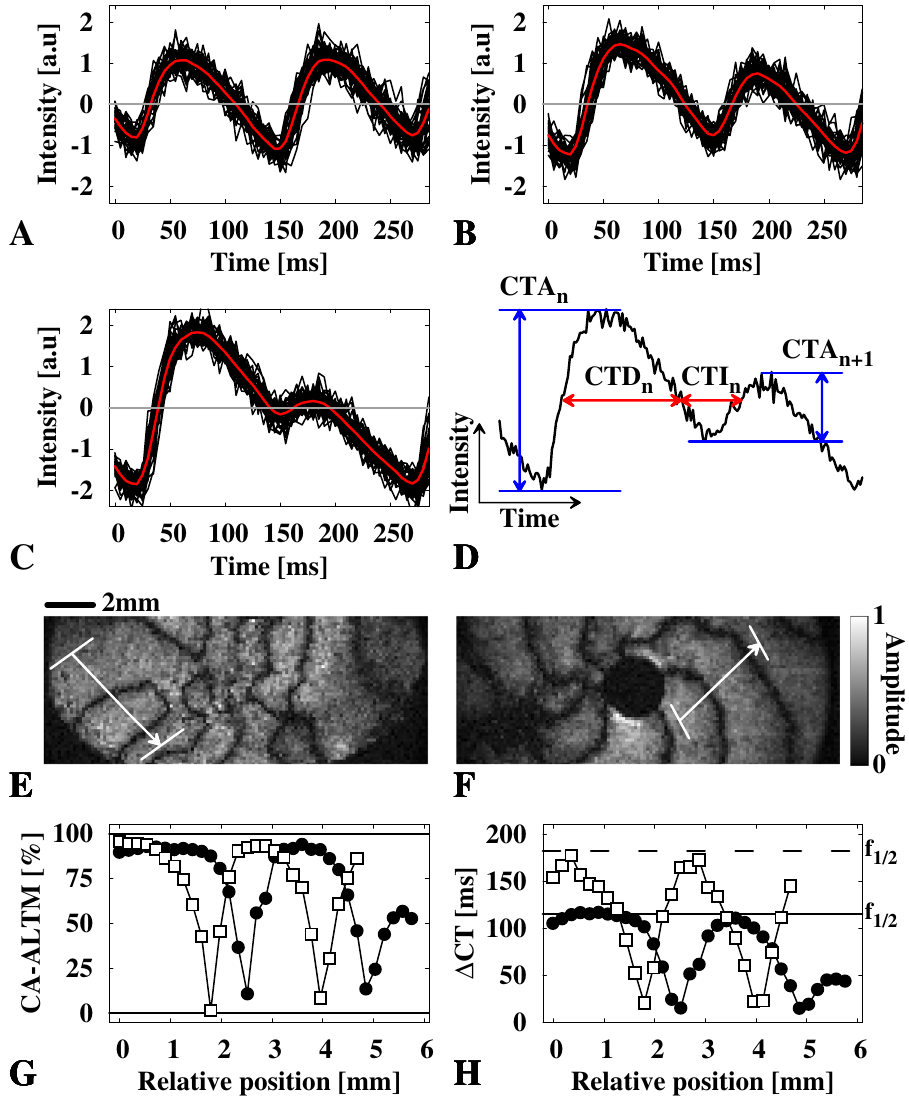
Figure 2. Analysis of spatially concordant alternans. ( A to C ) show three typical calcium signaling examples that are obtained using the signal oversampling technique (black lines). The average is shown as a red line that is used to quantify CA-ALTM and Δ CT (see Eqs (1) and (2)). A shows an example observed at a nodal line. ( B and C ) show examples of low (CA-ALTM ~ 100%) and strong (CA-ALTM ~ 50%) alternans, respectively. ( D ) shows an illustration of the cytosolic transient amplitude (CTA) and cytosolic transient duration/interval (CTD/CTI) in a typical single pixel recorded cytosolic calcium signal of high-frequency paced waves. CTD and CTI are determined by considering the intensity threshold at 50%. ( E and F ) show a free and an obstacle- anchored discordant alternating wave obtained by multidimensional Fourier analysis, respectively. The nodal lines are analyzed in line segments perpendicular to the nodal line orientation along a line segment of approximately 5 mm (see arrows in E ) and ( F ). ( G and H ) show the CA-ALTM and Δ CT calculated along the line segment by Eq. (1) and by Eq. (2), respectively. The black circles and white squares correspond to the examples shown in E and F,